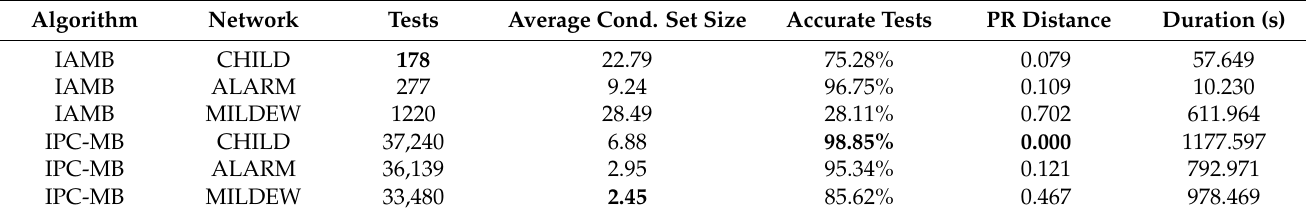
Table 5. G-test results across all datasets of 20,000 samples for IAMB and